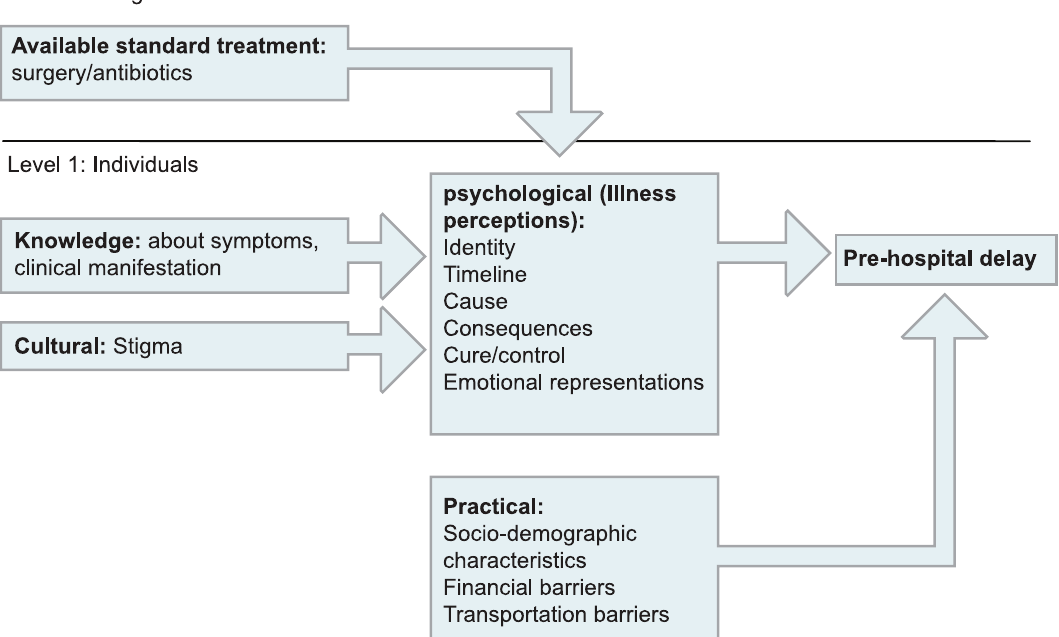
Figure 1. Model with level 1 and 2 factors potentially related to pre-hospital delay.